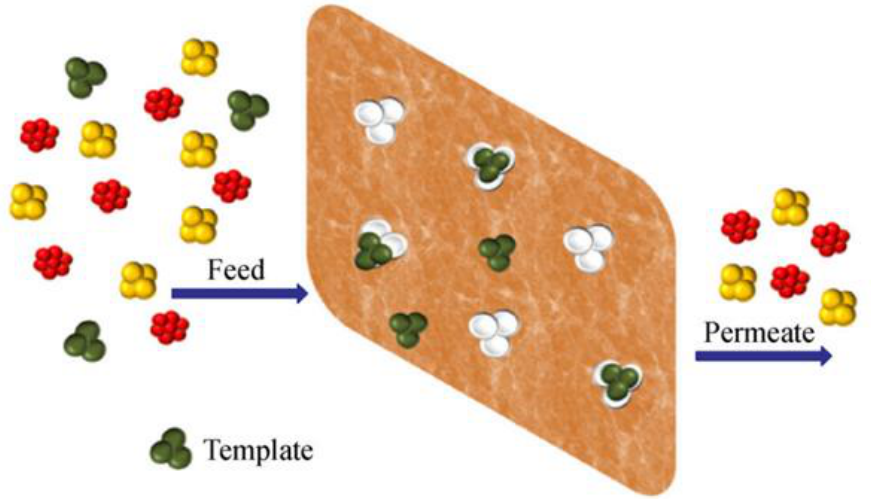
Figure 11. Representation of a flat-sheet molecularly imprinted membrane able to selectively bind the template molecules. (Reprinted with permission from Ref. [7]. Copyright 2021 Springer Nature.)